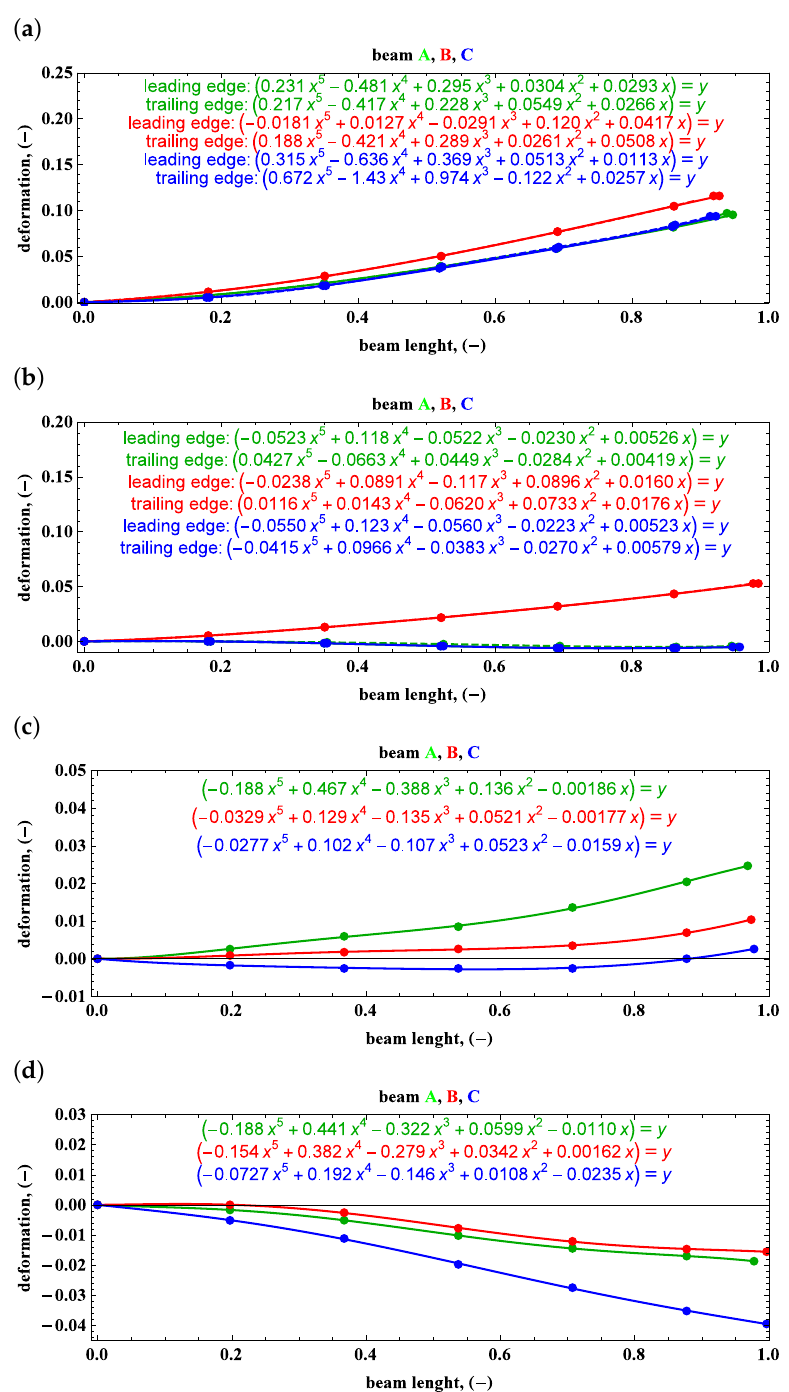
Figure 14. Side view—beam deformations and their description by polynomials: ( a ) preset angle 45 ◦ and angular speed 100 rpm, ( b ) preset angle 45 ◦ and angular speed 50 rpm, ( c ) preset angle 5 ◦ and angular speed 100 rpm, ( d ) preset angle 5 ◦ and angular speed 50